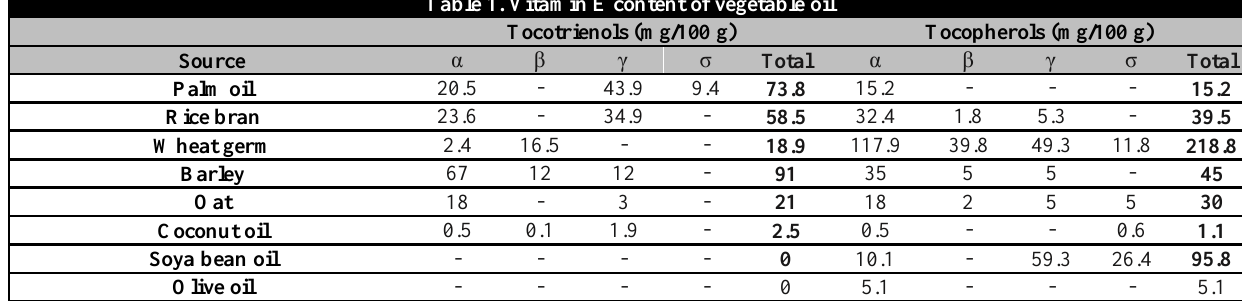
Table 1. Vitamin E content of vegetable oil Tocotrienols (mg/100 g) Tocopherols (mg/100